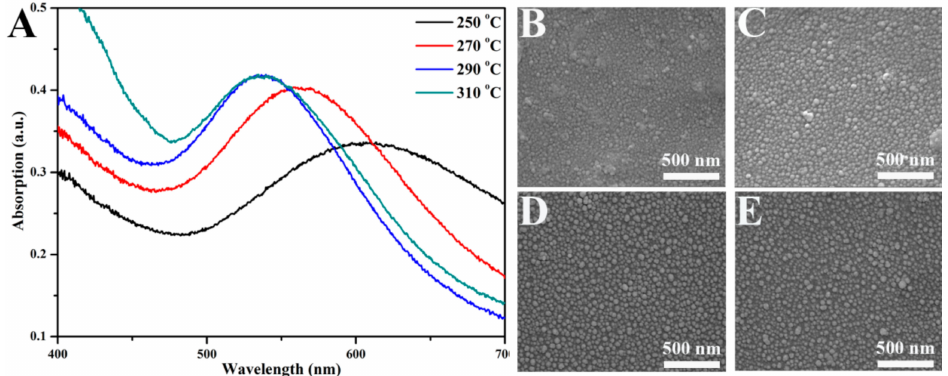
Figure 3. The LSPR spectra of the PEN / Au-Ag NPs after annealing at di ff erent temperatures ( A ). The corresponding SEM results of the PEN / Au-Ag NPs undergoing annealing at 250 ◦ C ( B ), 270 ◦ C ( C ), 290 ◦ C ( D ), and 310 ◦ C ( E